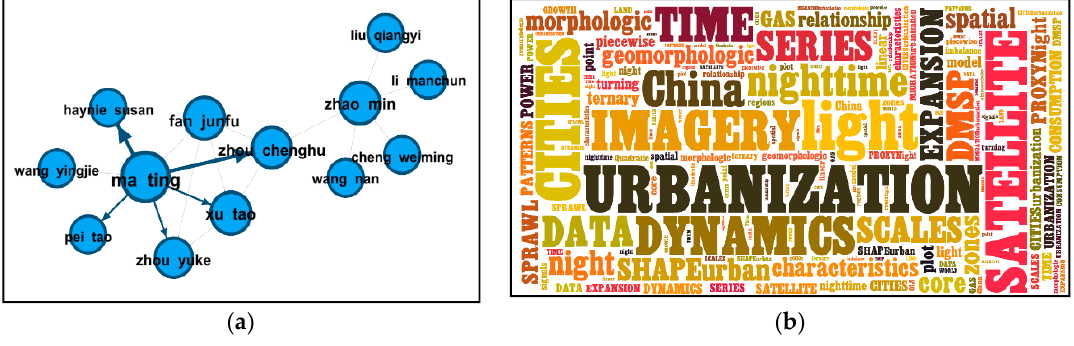
Figure 6. Ma, T.–Zhou, C.H. research community: ( a ) co-author network; ( b ) related topics. Table 6. Leading authors in the Ma, T.–Zhou, C.H. research community ranked by BC.